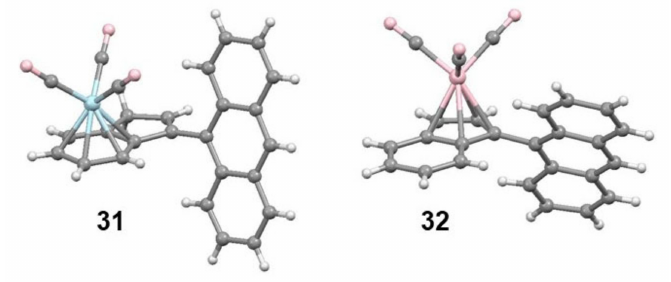
Figure 14. Molecular structures of [ η 6 -3-(9-anthracenyl)indene]tricarbonylchromium, 31 , and [ η 5 -3-(9- anthracenyl)indenyl]tricarbonylrhenium, 32